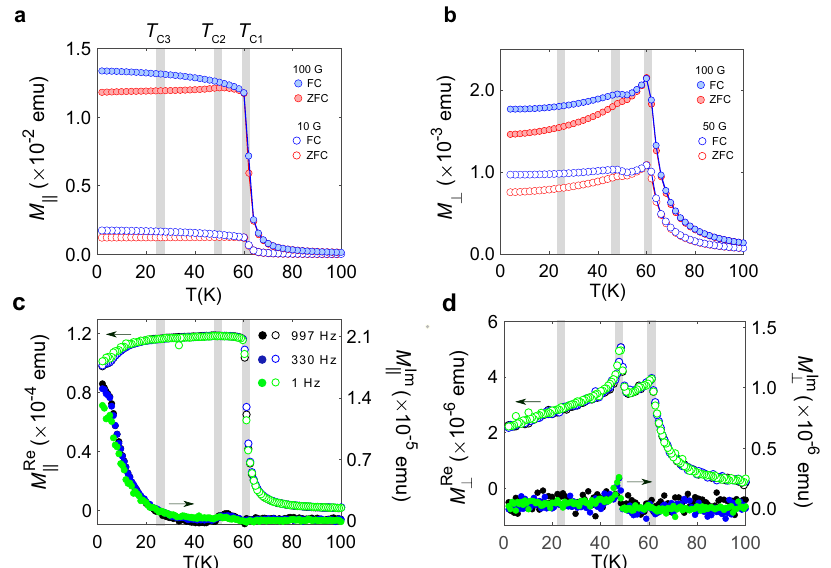
Fig. 3 SQUID magnetometry. a-b , Zero fi eld cooled (ZFC) and fi eld cooled (FC) temperature dependences of the DC magnetization M at external magnetic fi elds (10 G, 50 G, 100 G) aligned parallel ( M ∥ ) and perpendicular ( M ⊥ ) to the crystallographic c -axis, respectively. The grey-shaded regions indicate the critical temperatures ( T C 1 , T C 2 , T C 3 ) where the phase transitions occur as observed on the μ SR measurements. The solid lines are a guide to the eye. c-d , Zero- fi eld temperature dependences of the AC magnetization at parallel and perpendicular orientations, respectively. Three different frequencies (997 Hz, 330 Hz, 1 Hz) are used for plotting the real ( M Re k , M Re ? ) and imaginary ( M Im k , M Im ? ) parts of the AC